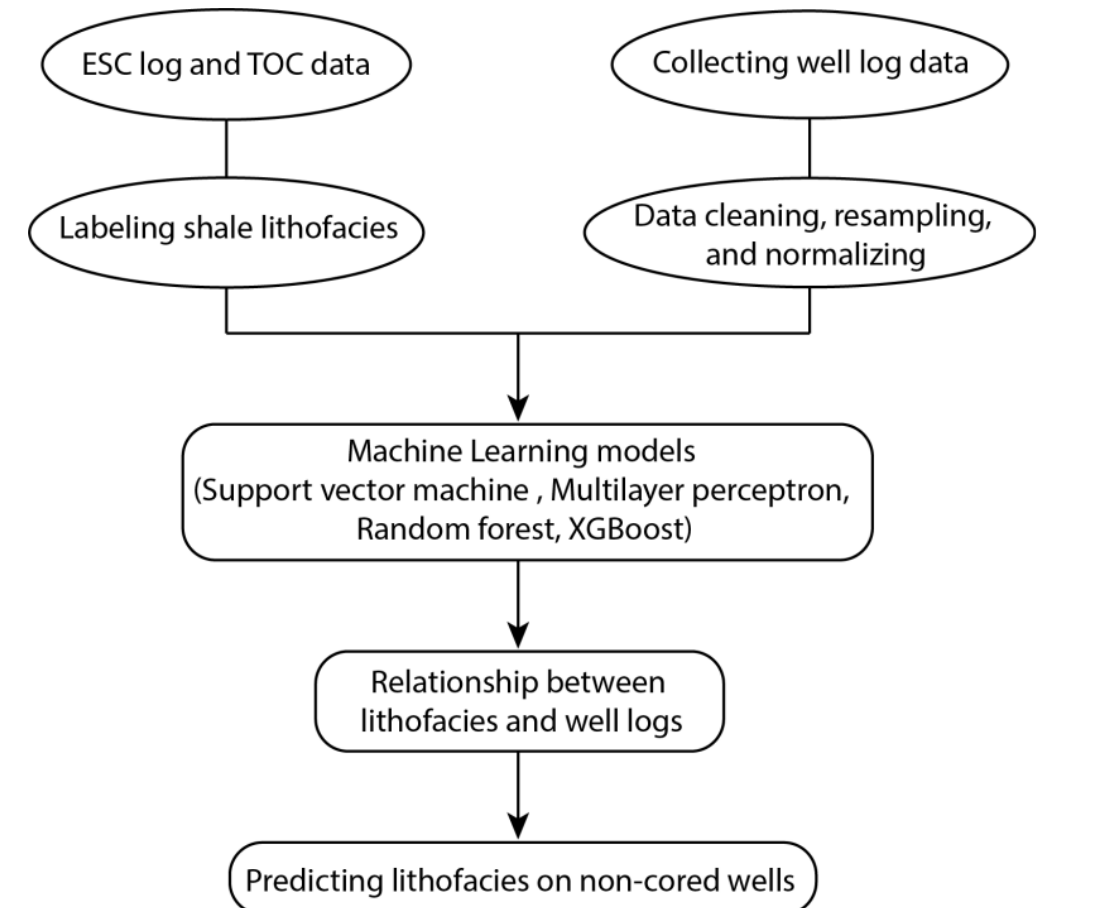
Figure 1. The flowchart illustrates the workflow of this study. Refer to the text for abbreviations of well logs and models.